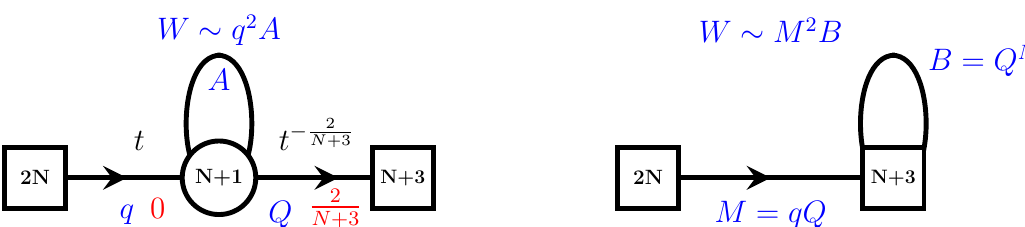
Figure 18: Spiridonov-Warnaar-Vartanov (SWV) S-confining duality. The line starting and ending on the same gauge node is in two index antisymmetric representation.